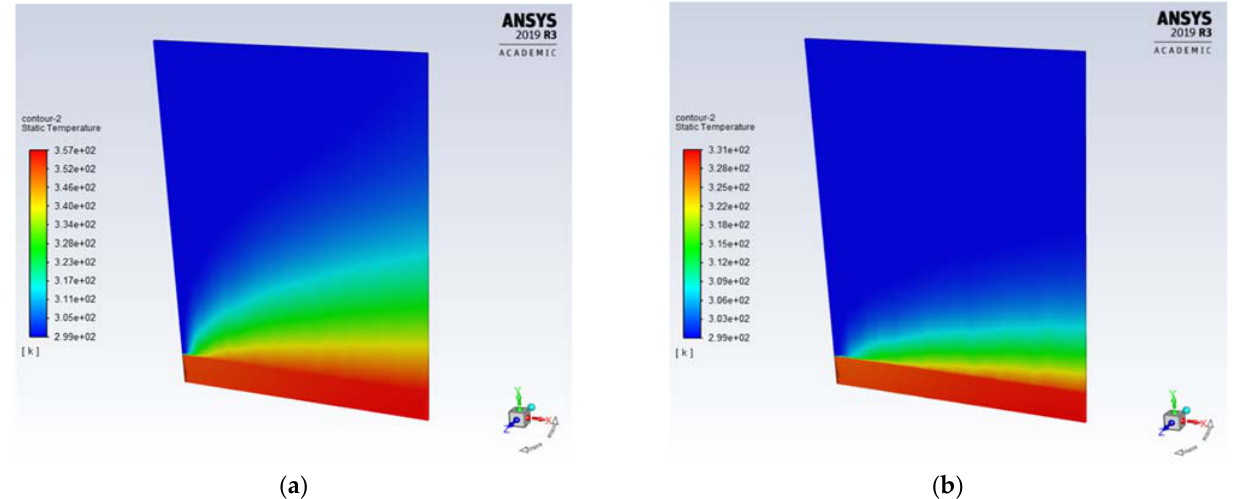
Figure 6. Temperature distribution for: ( a ) 𝑢 (cid:3042) = 2.50 m/s and ( b ) 𝑢 (cid:3042) = 2.71 m/s. Temperatures are given in K .